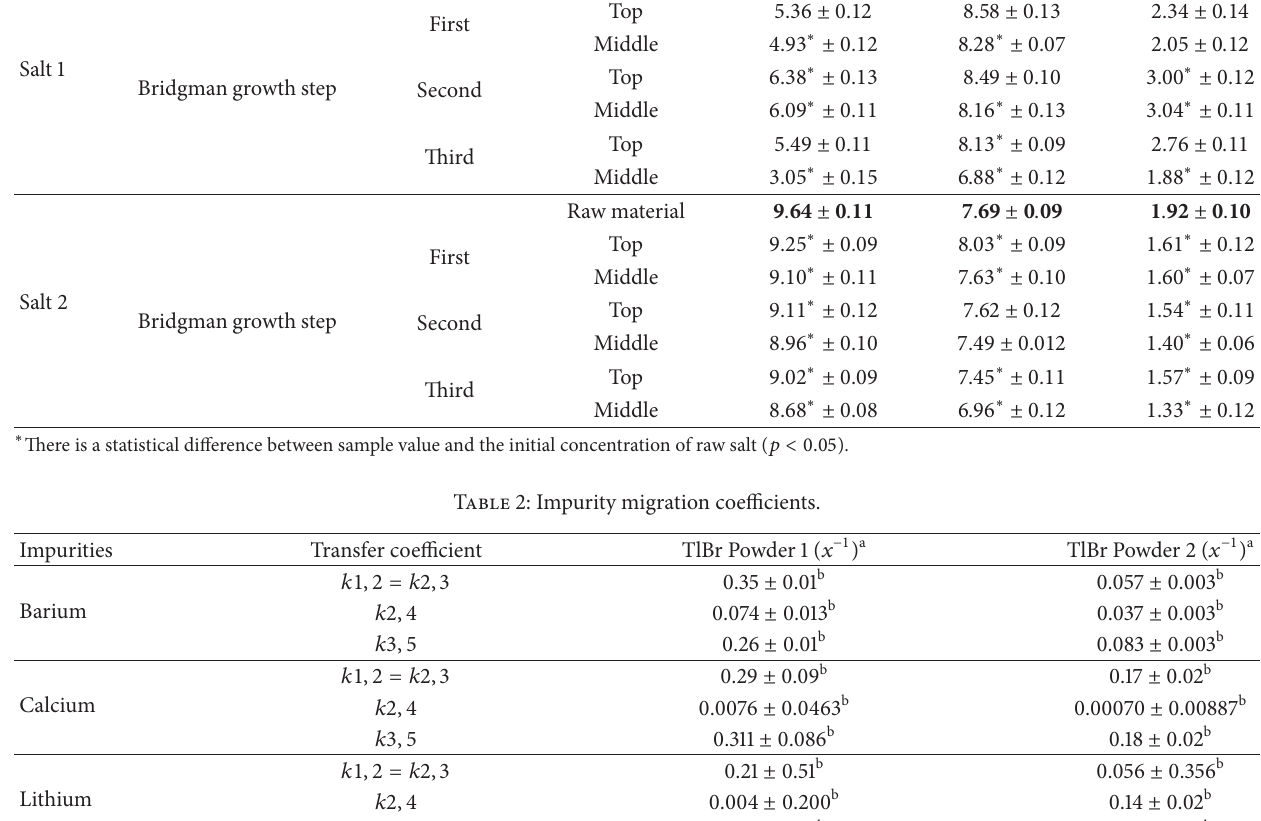
(Table 2) for the two salts, similar results can be